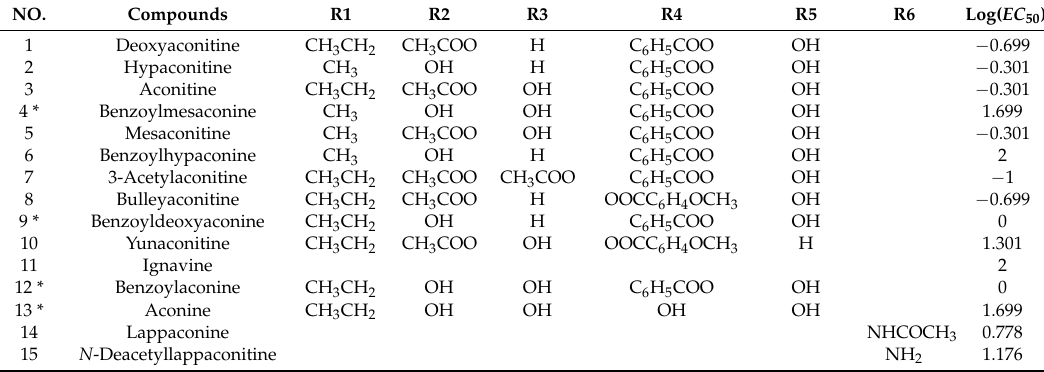
Table 3. The chemical structures of 15 diterpenoid alkaloids and Log( EC 50 ) values. NO.